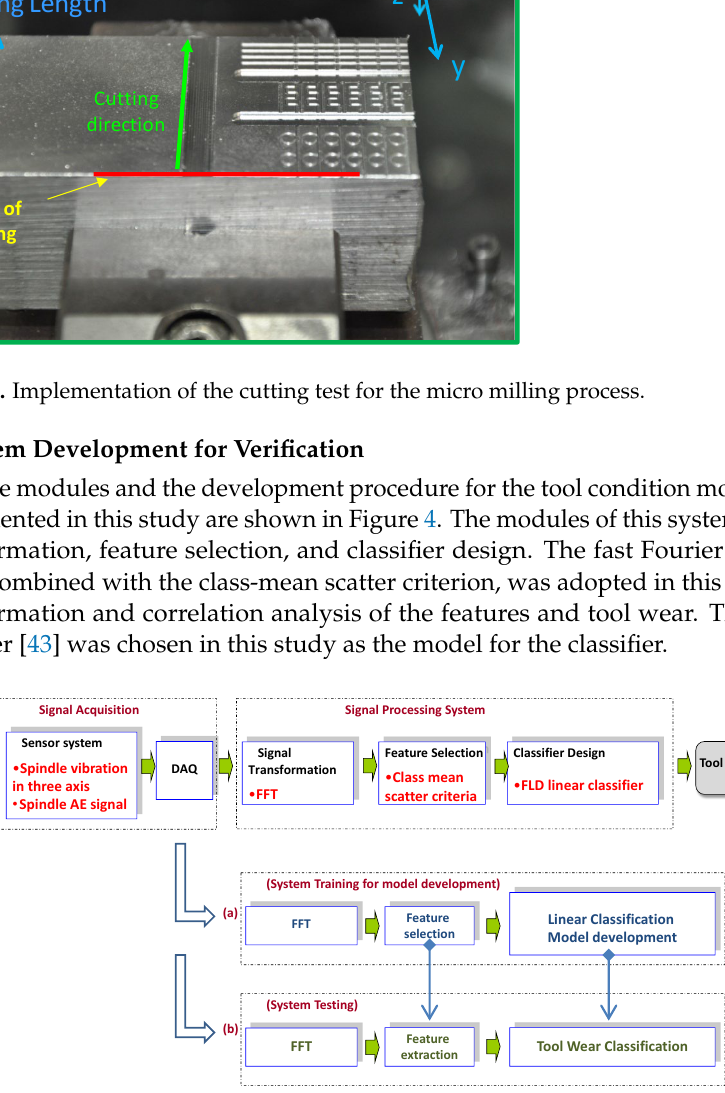
Figure 3. Implementation of the cutting test for the micro milling process. Table 1. Cutting conditions.